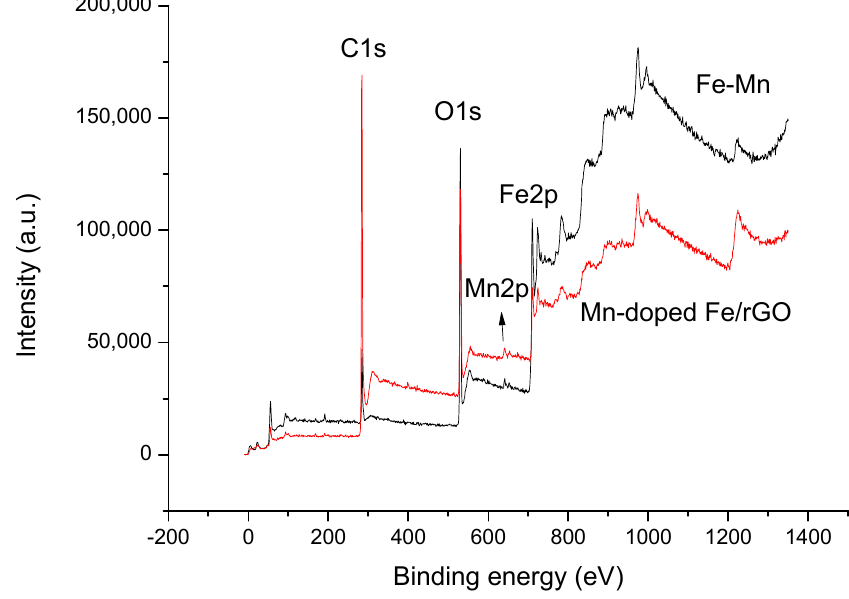
Figure 8. XPS survey spectra of Fe–Mn NPs and Mn-doped Fe/rGO composites.